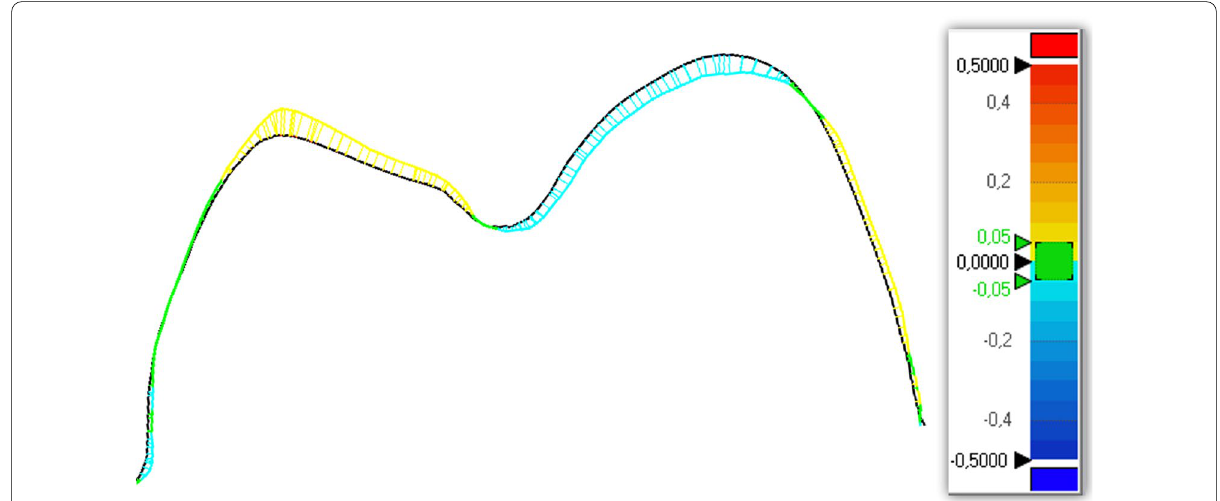
Fig. 1 Cross section of the color-coded superimposed